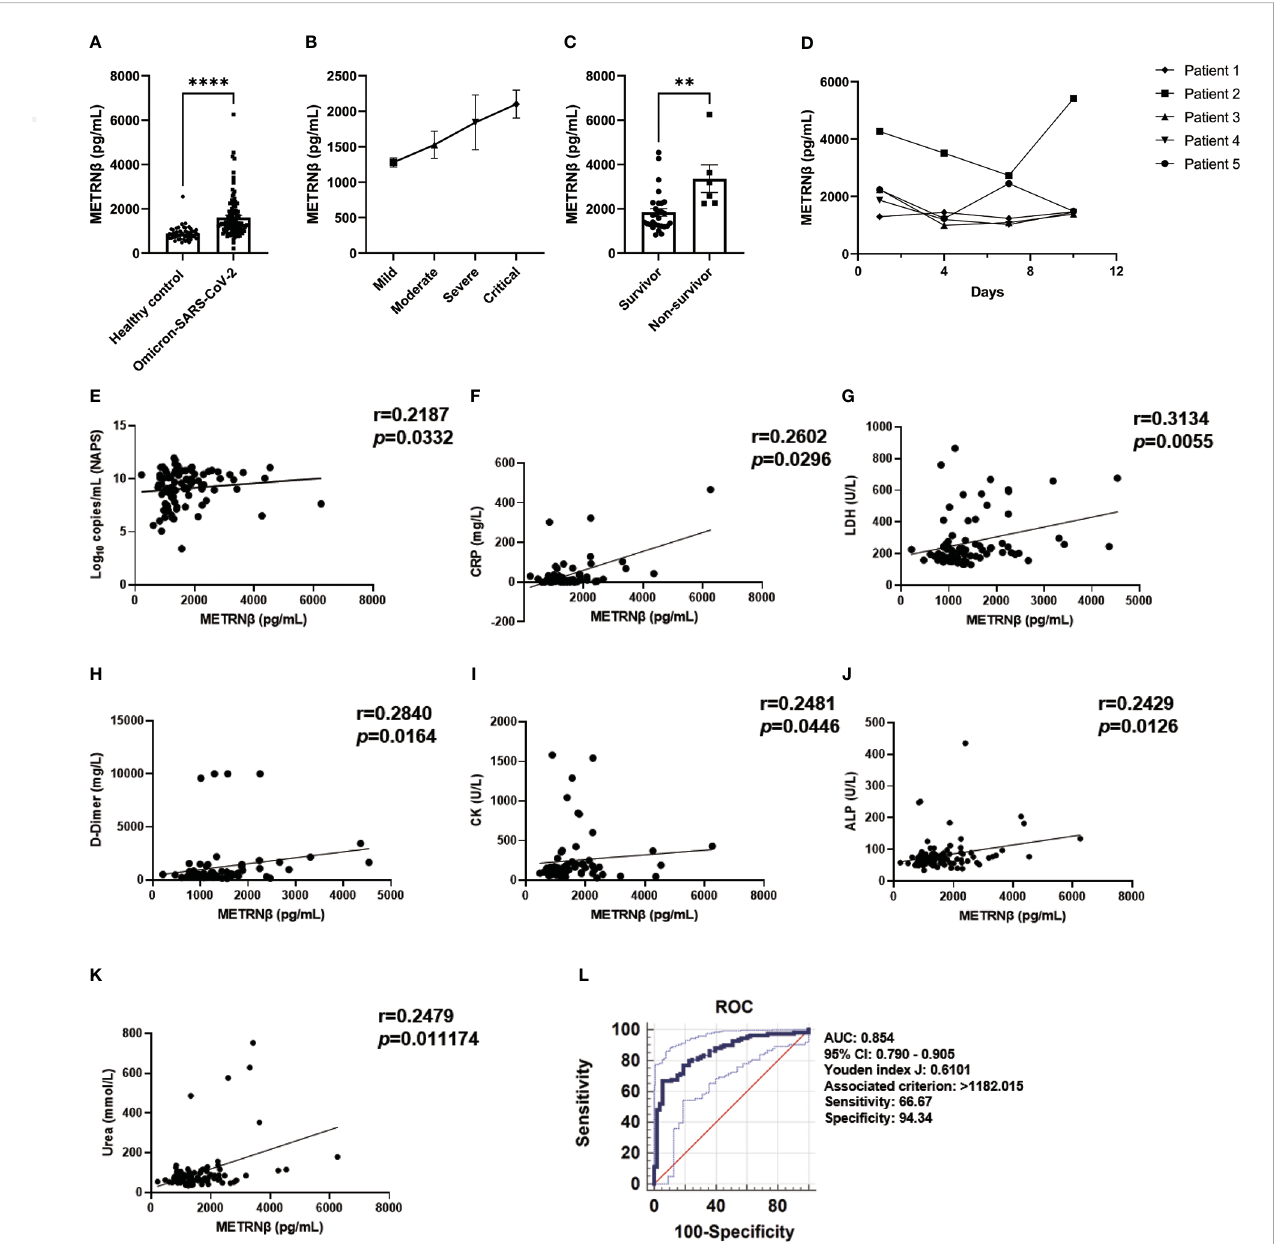
FIGURE 5 METRN b concentration was elevated in the validation cohort of Omicron-SARS-CoV-2 infected COVID-19 patients on admission. (A) Circulating METRN b concentrations in COVID-19 patients infected with Omicron-SARS-CoV-2 (n = 108) and healthy controls (n = 53) detected by ELISA. (B) COVID-19 patients were strati fi ed into mild (n = 54), moderate (n = 9), severe (n = 10), and critical groups (n = 35). Circulating METRN b levels in serum were detected with ELISA. (C) Serum METRN b concentration of the non-survivors (n = 6) and survivors (n = 29) among the critical patients measured by ELISA. (D) Dynamic change of circulating METRN b concentrations in 5 Omicron-COVID-19 patients on the day of administration and 4 days, 7 days, and 10 days after administration (n = 5). (E) Correlation analysis of serum METRN b concentration with viral loads in the NAPS in patients with Omicron SARS-CoV-2 infections (n = 95). (F – K) Correlation analysis of serum METRN b concentration with CRP (n = 70), LDH (n = 77), D-dimer (n = 71), CK (n = 66), ALP (n = 105), and urea (n = 104) in patients with Omicron-SARS-CoV-2 infections. (L) ROC of serum METRN b levels on admission to distinguish COVID-19 patients from healthy controls. The AUC was 0.854 (95% CI: 0.790 – 0.905) for serum METRN b levels on admission in the validation cohort of Omicron-SARS-CoV-2 infections (n = 108). Data were shown as the mean ± SEM. The Mann – Whitney test or Kruskal – Wallis